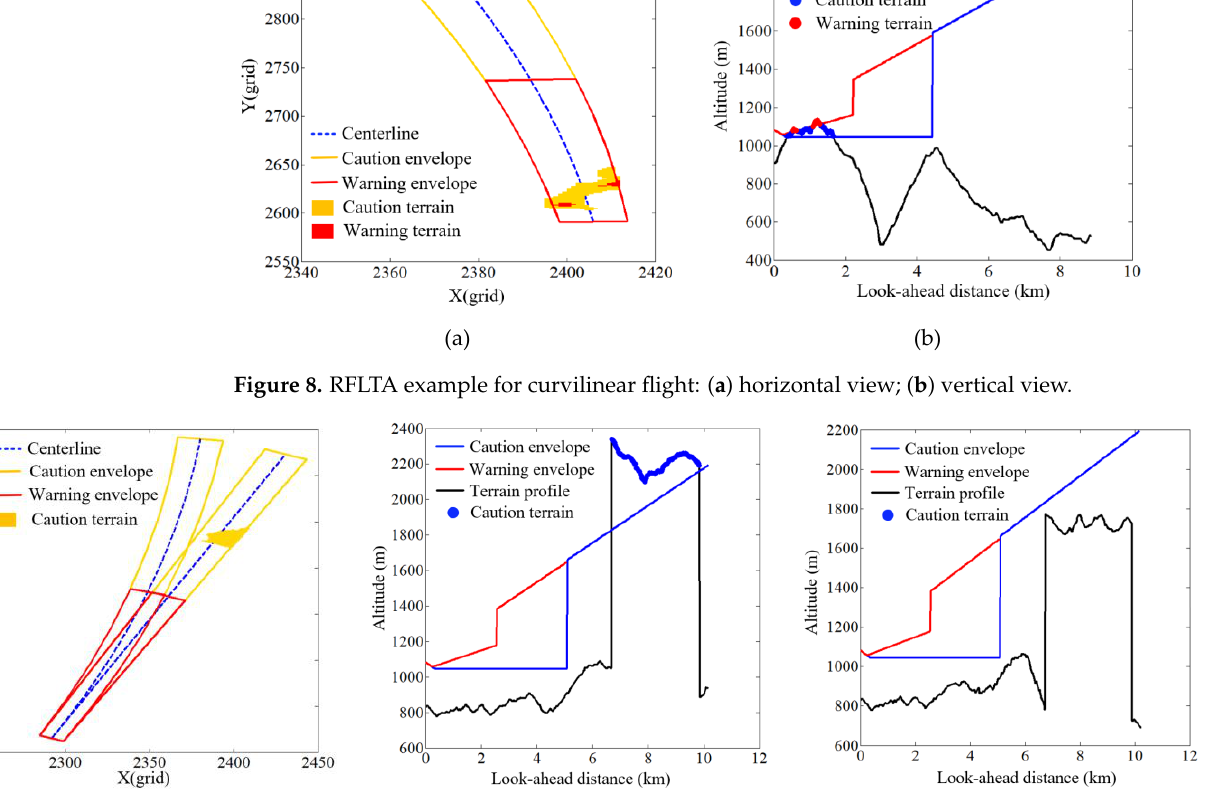
253 Figure 10. Two boundaries on the horizontal flight curve. 254